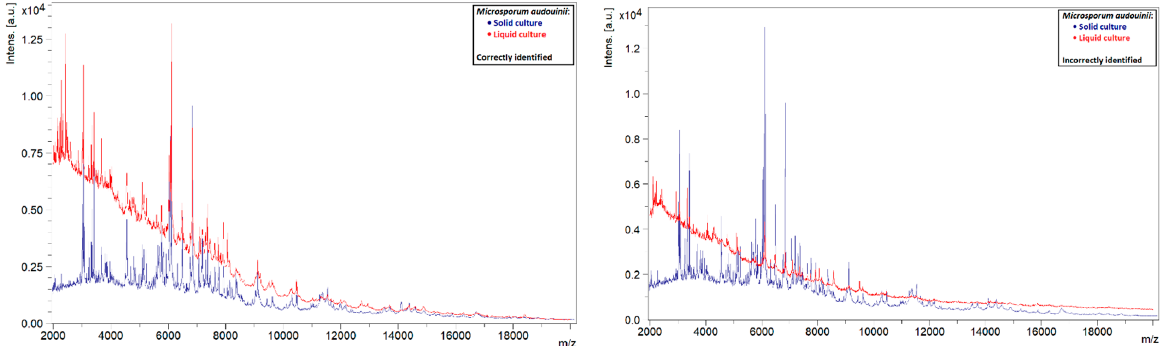
Figure 5. Comparison of the spectra of solid and liquid cultures of M. audouinii , on the left a correctly identified liquid culture and on the right an incorrectly identified liquid culture.